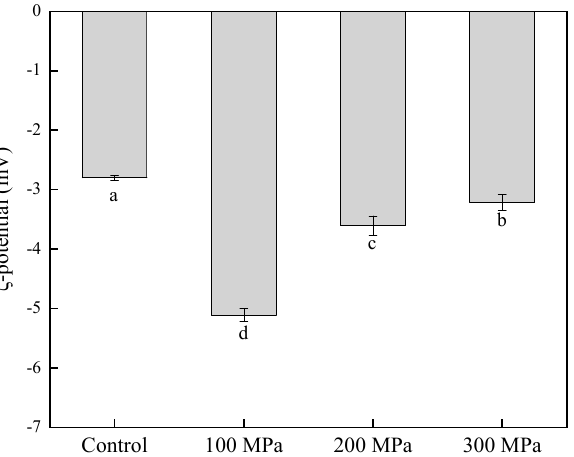
Figure 5. Effect of HHP pretreatment on the ζ -potential of RBPH. HHP: high hydrostatic pressure; RBPH: rice bran protein hydrolysates. Control, 100 MPa, 200 MPa, and 300 MPa represent RBPH samples subjected to 0, 100, 200, and 300 MPa pretreatment, respectively. Different lowercase letters indicate values that differ significantly ( p < 0.05). All the HHP pretreatments were conducted at 25 ◦ C for 30